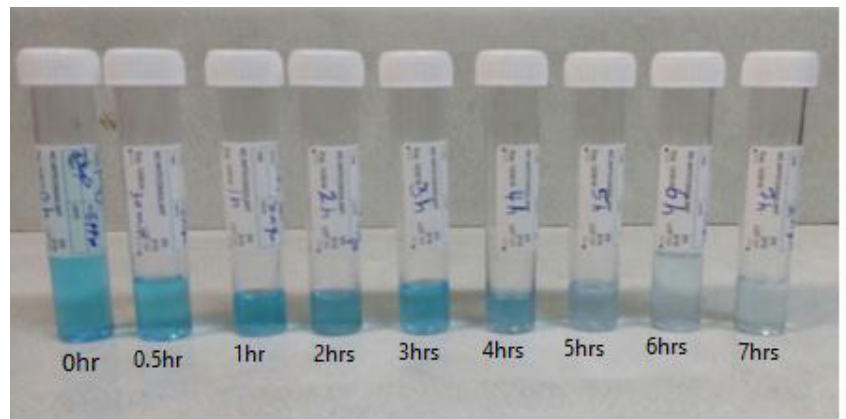
Fig.5: Decoloration of 5 ppm MB by